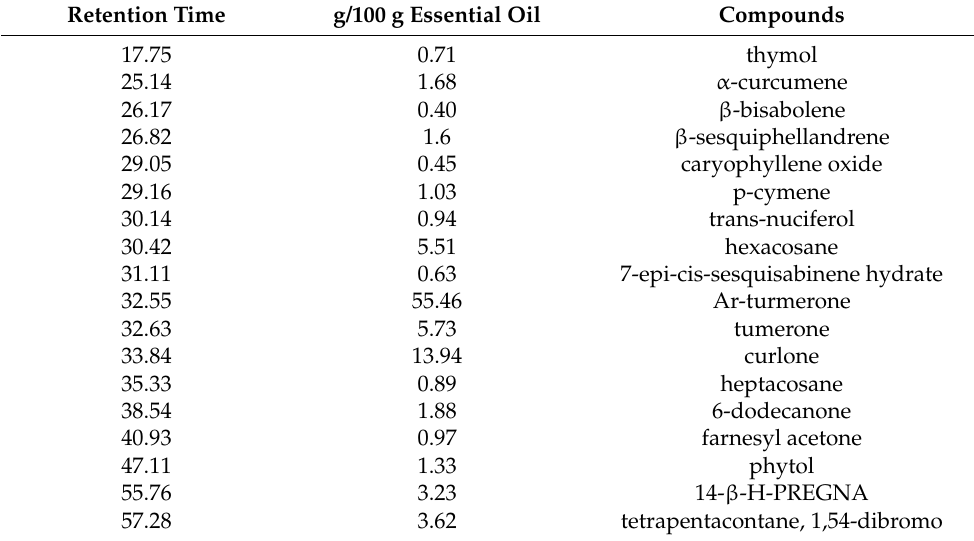
Table 2. The main compounds in the Moringa